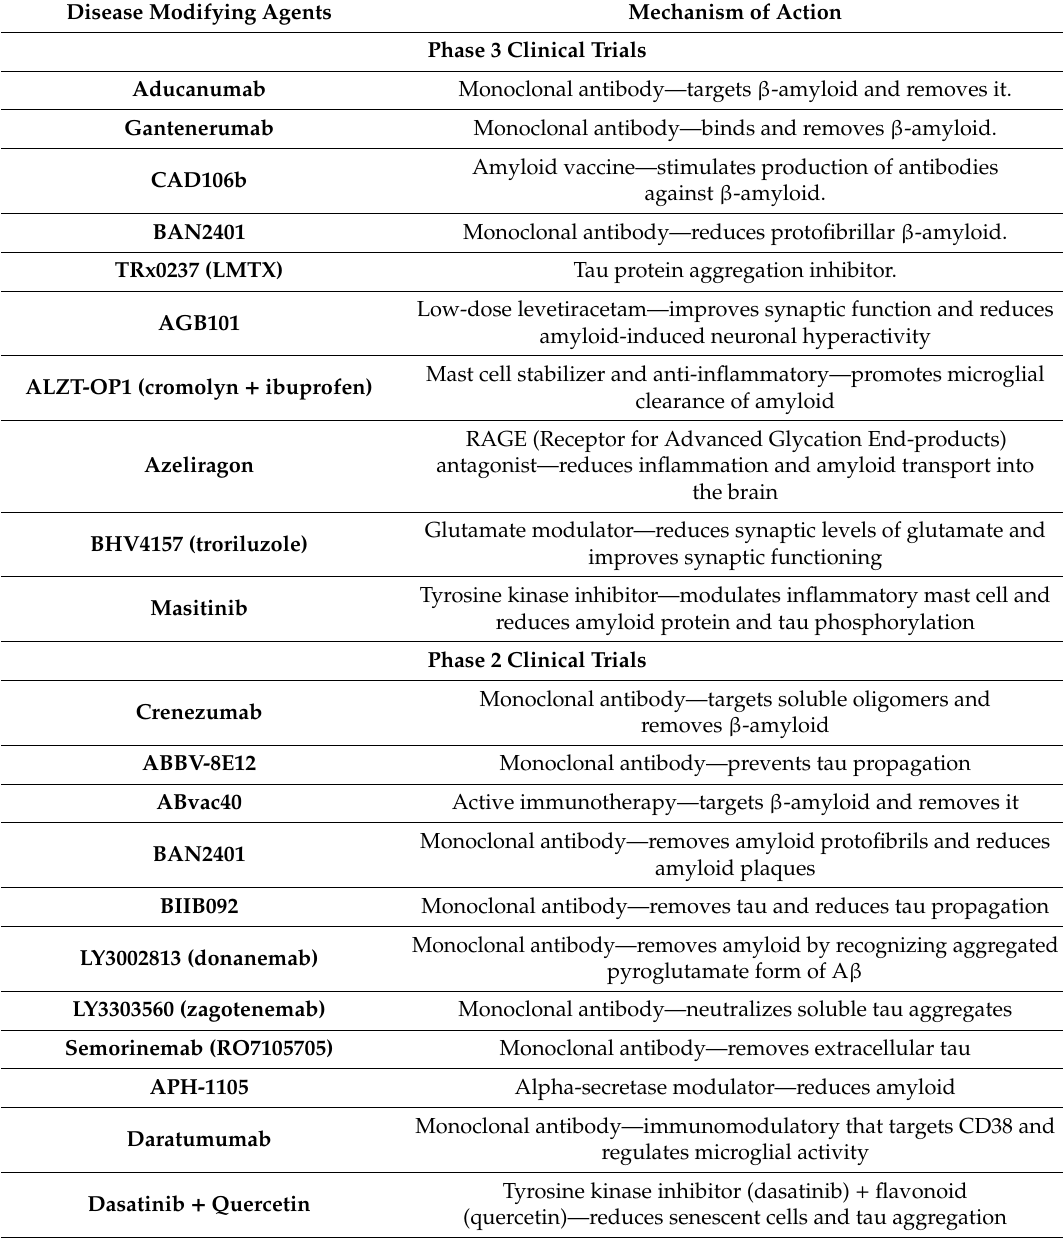
Table 1. Disease modifying agents for the treatment of Alzheimer’s disease in clinical trials. Disease Modifying